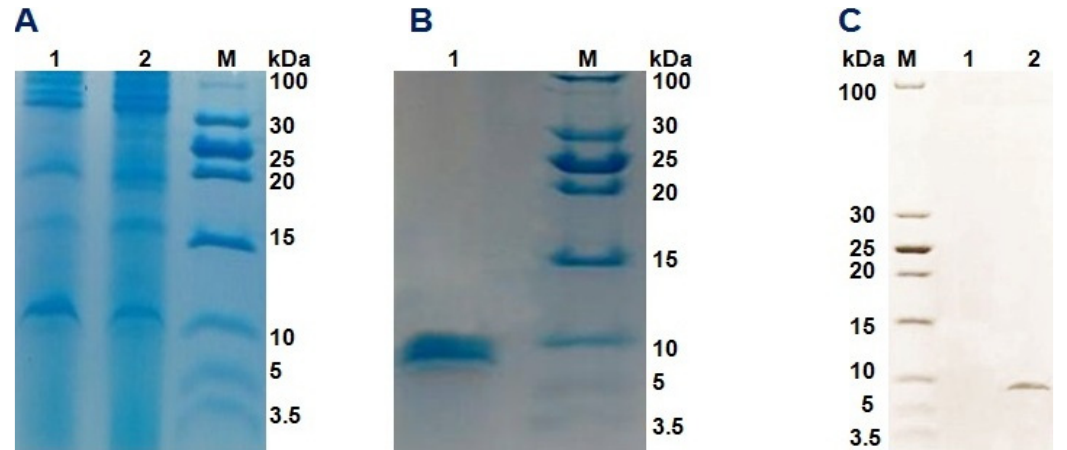
Figure 4. Tricine-SDS-PAGE and Western blot analysis of DLP4 expressed in Pichia pastoris . ( A ) Analysis of proteins of the broth supernatant from the crude culture of DLP4-expressing GS115; Lanes 1 and 2: the culture supernatant samples collected at 96 h and 120 h of incubation, respectively; M, low range unstained protein marker. ( B ) Analysis of the purified DLP4; Lane 1: Nickel affinity chromatograph of the purified-DLP4; M, low range unstained protein marker. ( C ) Western blot result of the purified-DLP4; M: low range unstained protein marker; lane 1: supernatant of GS115/pGAPZ α A; lane 2: purified DLP4.